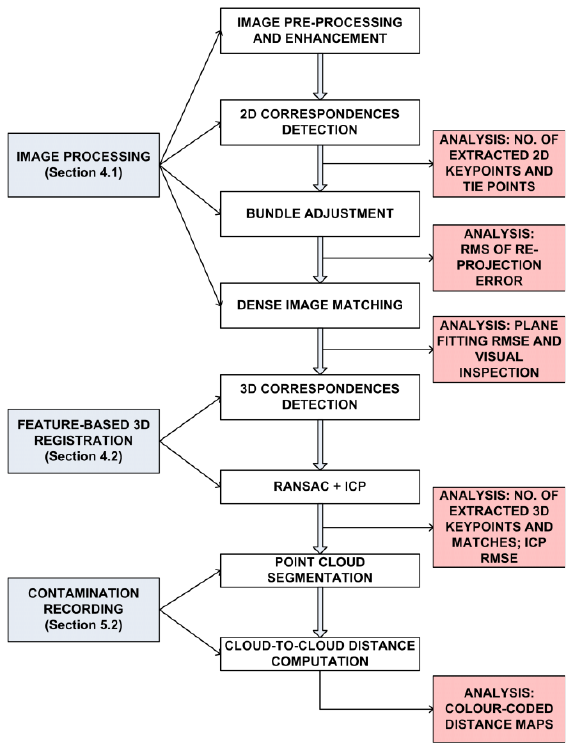
Figure 3. The workflow adopted in the